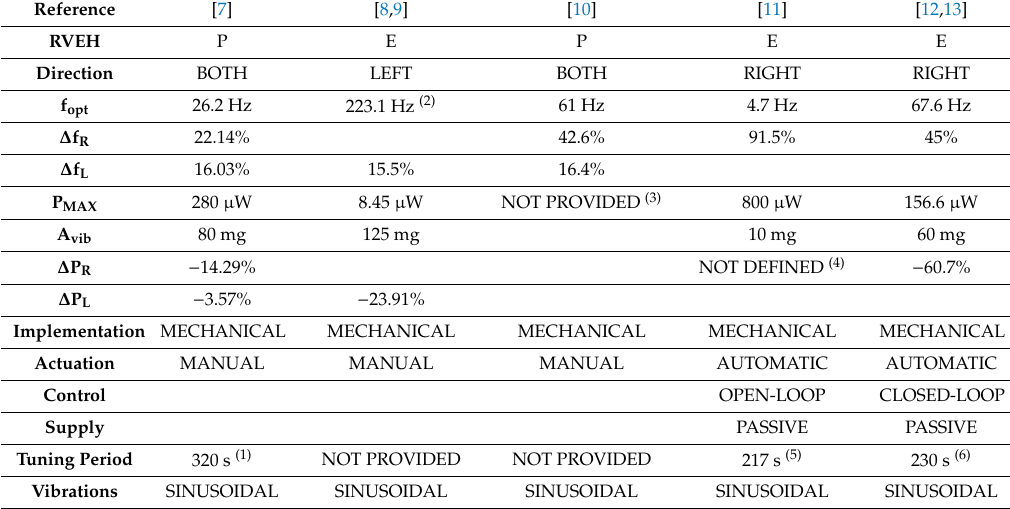
Table 2. Magnetic forces based MTTs classification